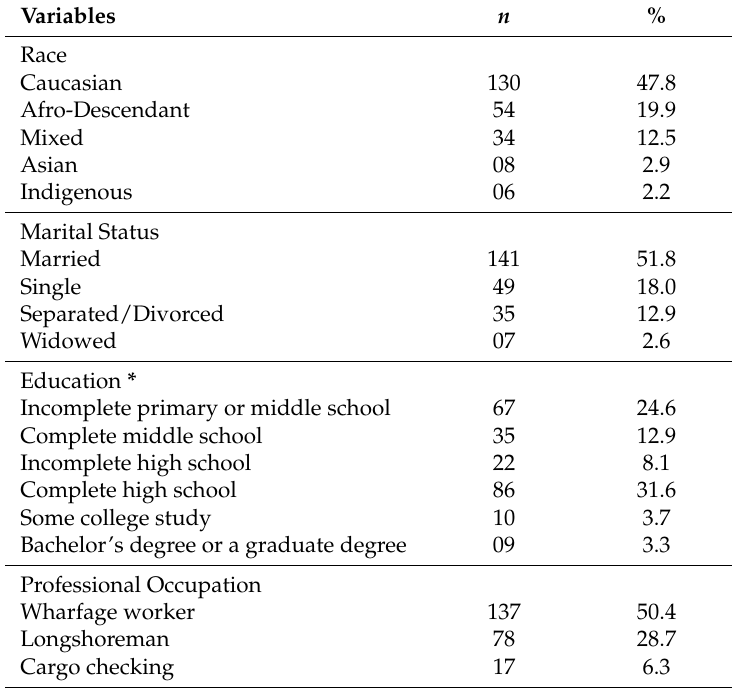
Table 1. Sociodemographic and occupational characteristics of dockworkers in the interior of the state of Rio Grande do Sul,